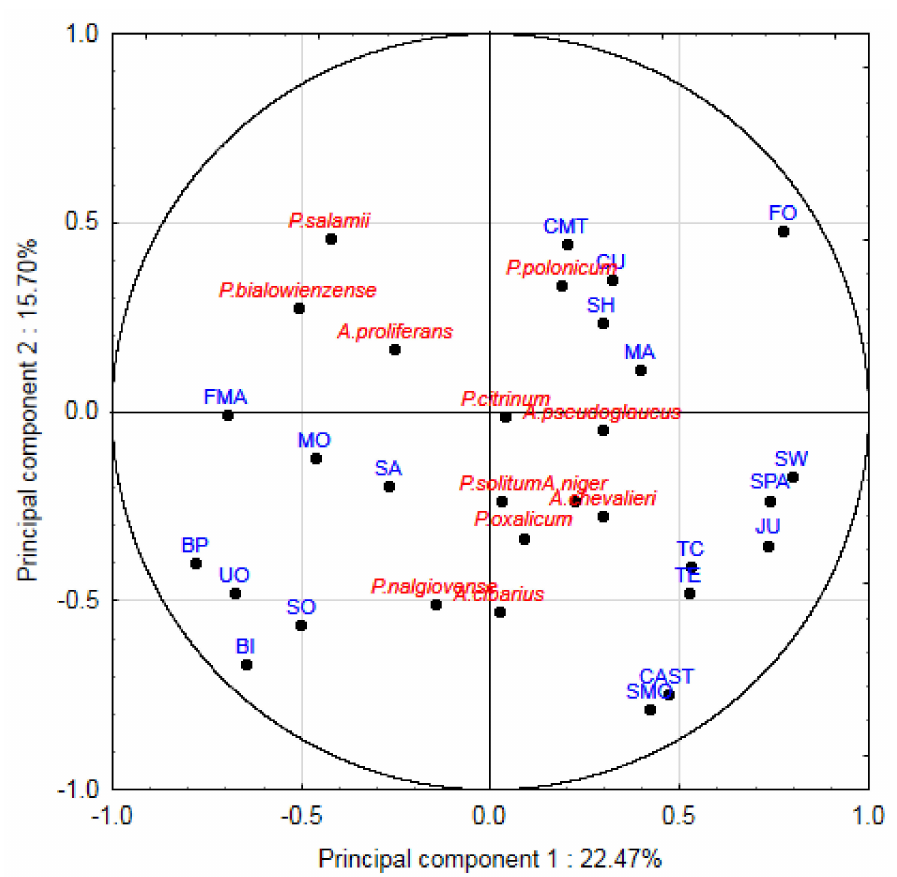
Figure 2. Score plot of the variables encompassed by the principal component analysis of sensory attributes and mould species of “Istarski pršut” and “Dalmatinski pršut”. CMT = colour of the muscle tissue; CAST = colour of the subcutaneous adipose tissue; CU = colour uniformity; MA = marbling; SH = surface humidity; TC = tyrosine crystals; FO = favourable odour; UO = unfavourable odour; SMO = smoky odour; TE = tenderness; JU = juiciness; SA = saltiness; SW = sweetness; SO = sourness; BI = bitterness; SPA = specific aroma; BP = biochemical properties; FMA = fresh meat aroma; MO =